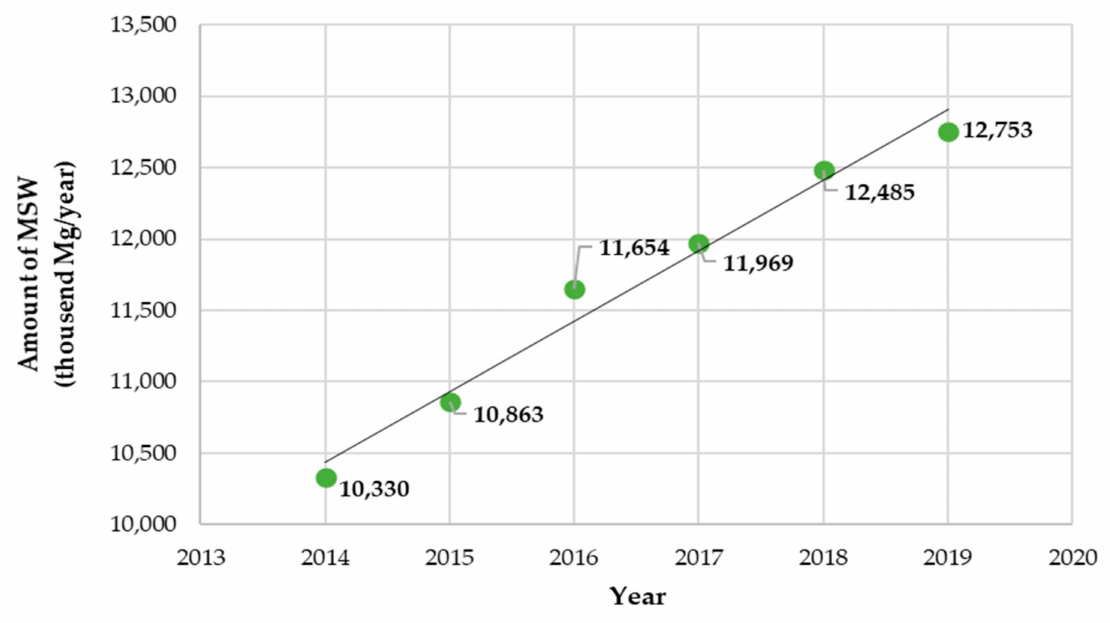
Figure 1. Increase in the amount of municipal waste generated in Poland in 2014–2019 (according to